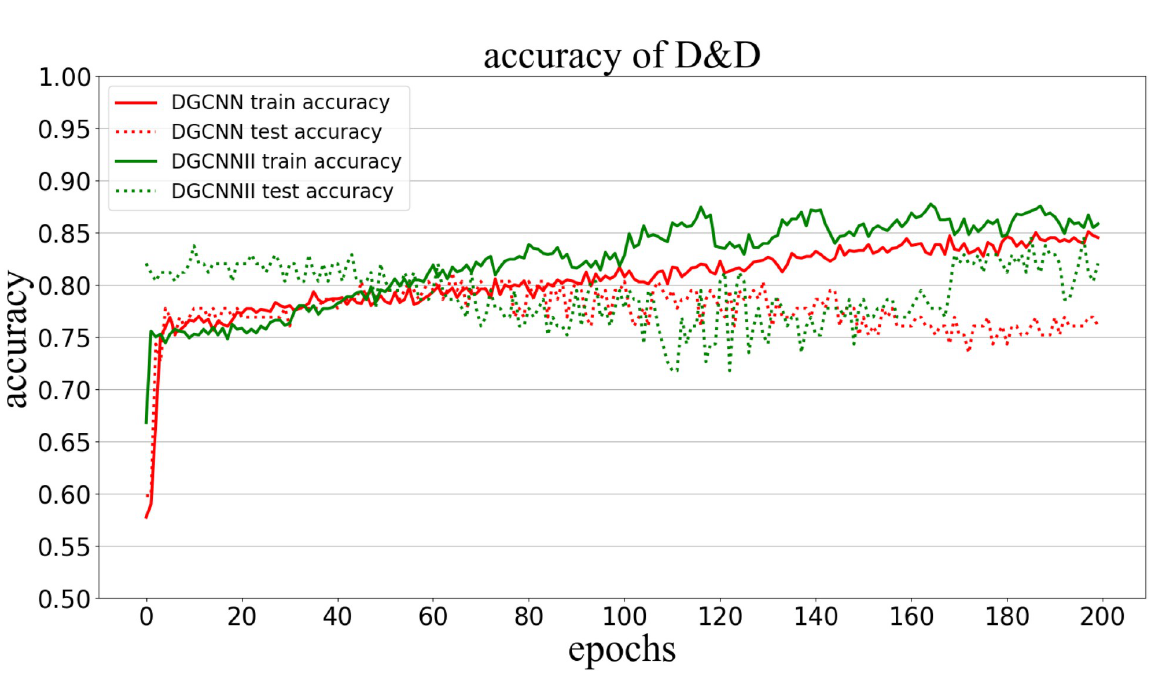
Fig 9. Comparison of graph classification accuracy between DGCNNII and DGCNN on D&D dataset.